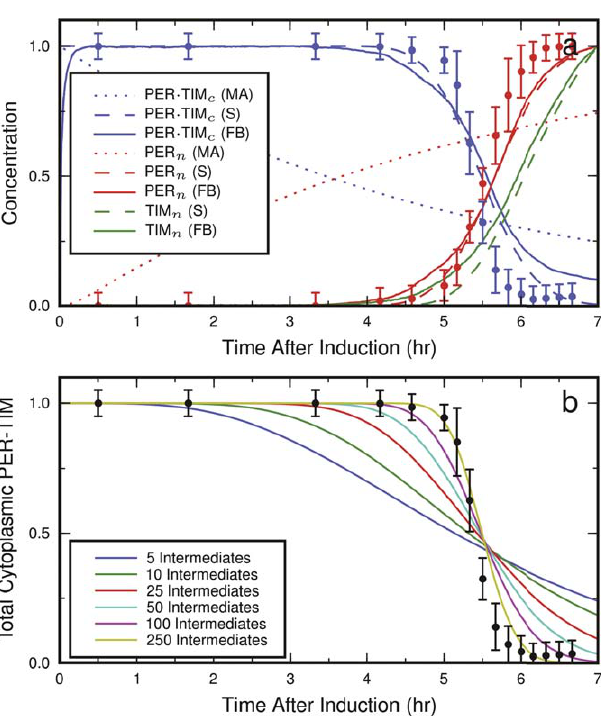
Figure 3. Results of the Isolated per / tim Loop Models versus Experimental Data Adapted from Meyer et al. [21] (Points with Error Bars) (A) Five hours after induction, the isolated per / tim loop from the simple mass action (MA) model results show PER is nuclear but without the precipitous change in PER–TIM stability and PER localization. Both the serial (S) (100 intermediates) and the feedback (FB) model results are consistent with experimental observations, showing a precipitous dissociation or PER–TIM followed by the nuclear accumulation of PER and TIM. (B) The serial model requires hundreds of intermediate states to be consistent with experimental observations. Model results and exper- imental data were scaled to a maximum of 1.0. Subscripts denote cytoplamic ( c ) or nuclear ( n ) localization.